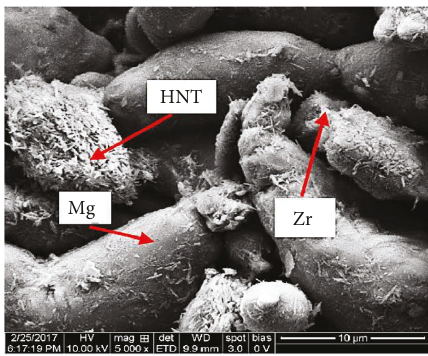
Figure 3: SEM micrograph of the well-mixed powder structure. Table 2: Machining factors and levels